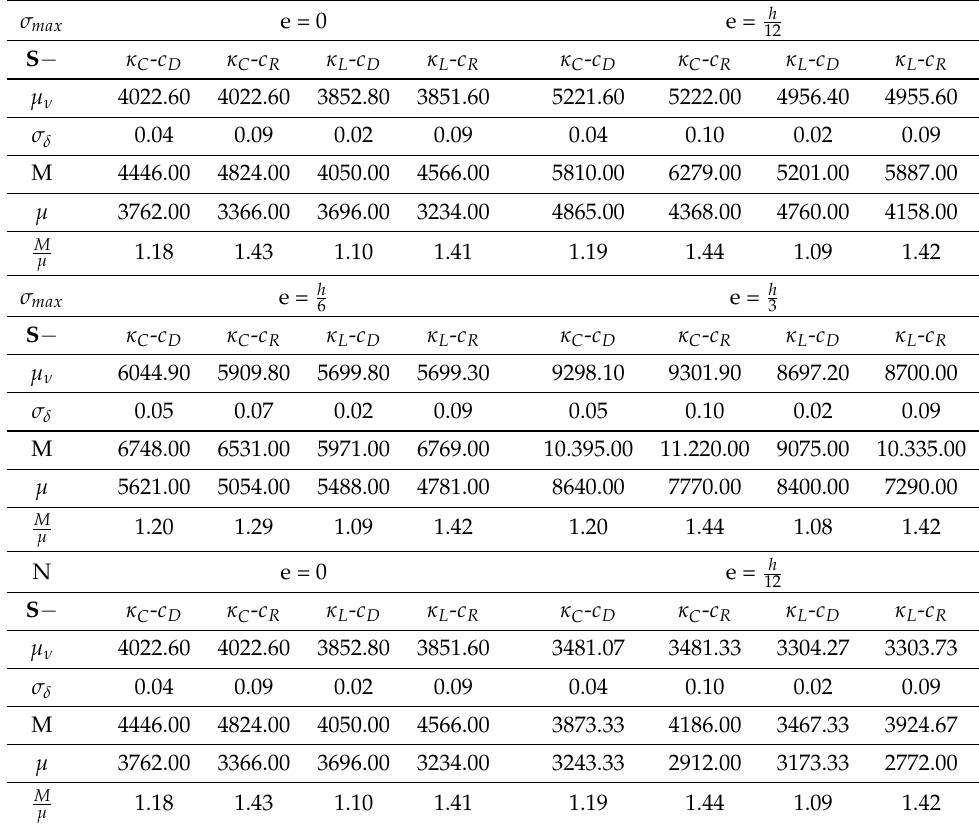
Table A1. Monte Carlo results for the maximum stress, (kPa) the normal force, (kN) the maximum and minimum displacements, (m) and the rotation of the foundation (rad) for non-porous medium. µ ν , σ δ , M, µ stand for the mean value, the coefficient of variation, the maximum and the minimum value of the output random vector. σ max , N, u max , u min , φ denote the maximum footing settlement stress, the foundation axial force at failure, the maximum failure displacement, the minimum failure displacement and the corresponding rotation of the shallow foundation,